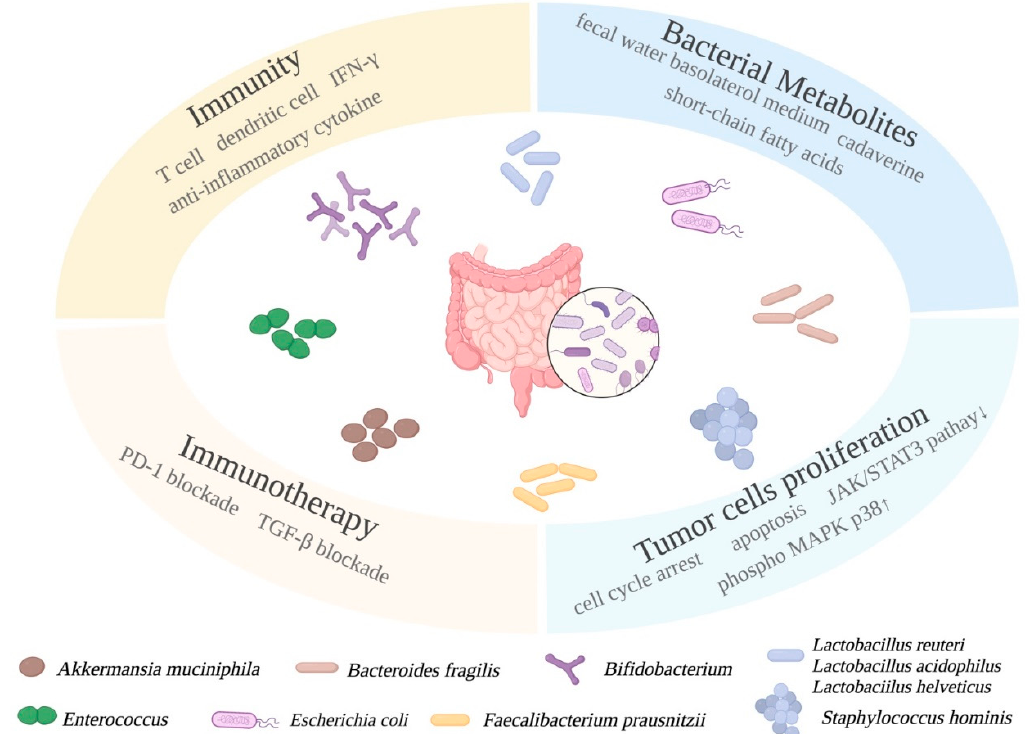
Figure 2. Probiotics and beneficial bacteria with probiotics effects in BC. A higher abundance of beneficial bacteria was associated with induced protective immune responses and improved conventional immunotherapy treatments. Bacterial metabolite profiles were changed. Anti-cancer mechanistic roles of probiotics were mediated by inhibited tumor cell survival and induced apoptosis.